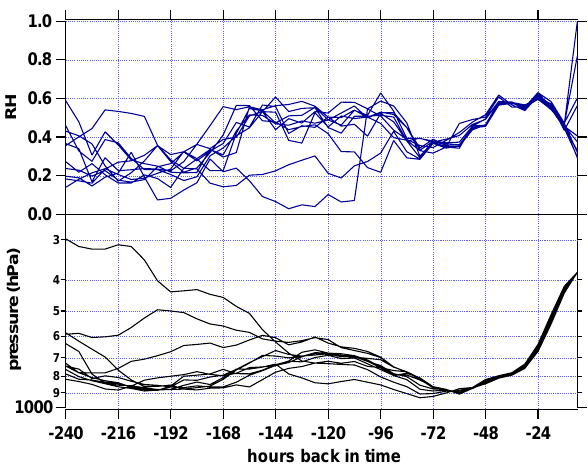
Fig. 9. Pressure and relative humidity along back trajectories calcu- lated with the OFFLINE model for every minute during plume II. The data points at 0h represent in-situ